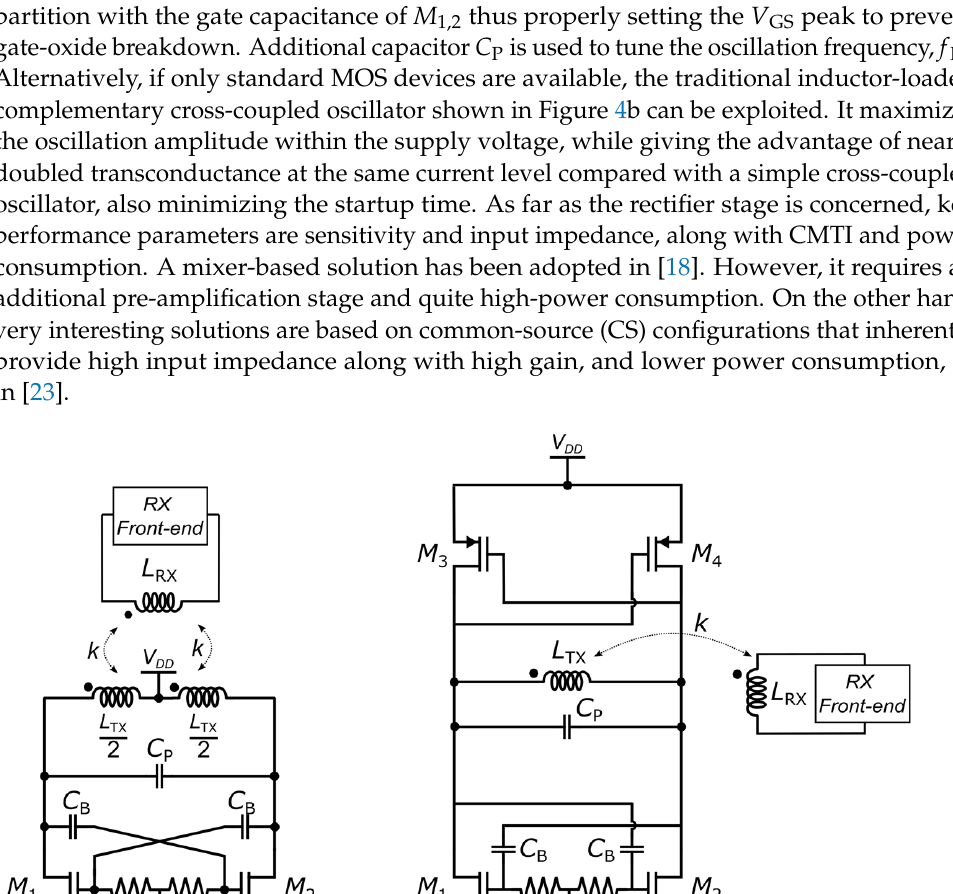
Figure 4. RF oscillator topologies for galvanic isolator based on RF coupling: D class oscillator ( a ); complementary cross-coupled oscillator ( b ).